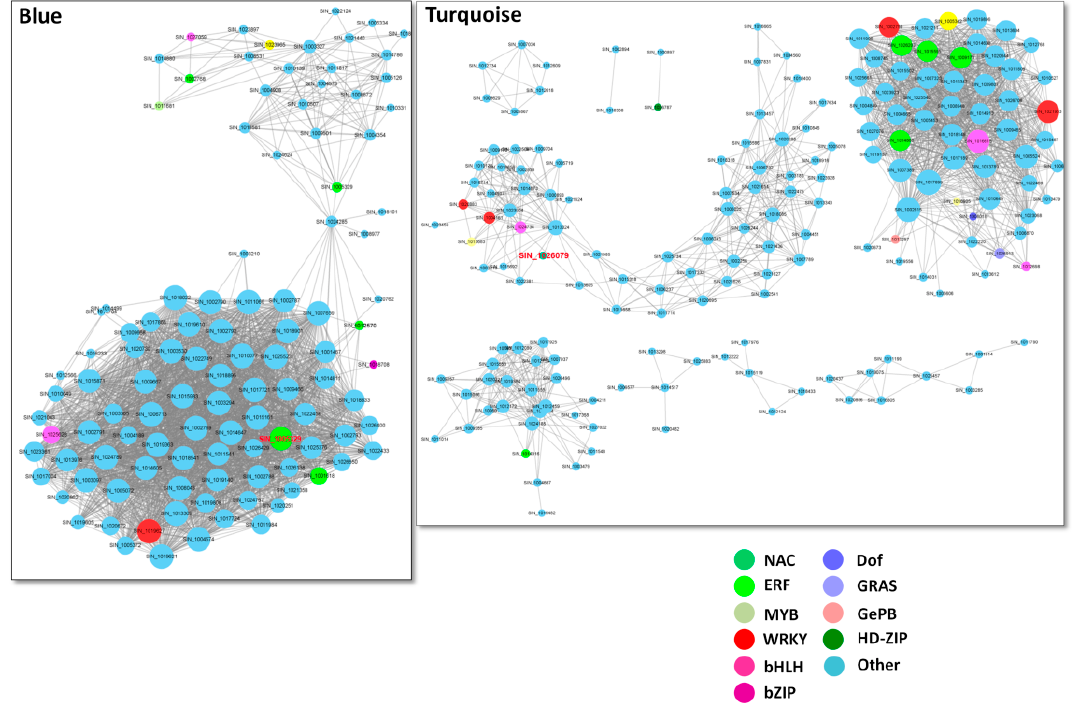
Figure 3. Co-expressed network analysis of Blue module and Turquoise module. The size of node circle is positively correlated with the number of the interacting gene partners. The gene names marked in red are those selected for validation using transgenic Arabidopsis approach.